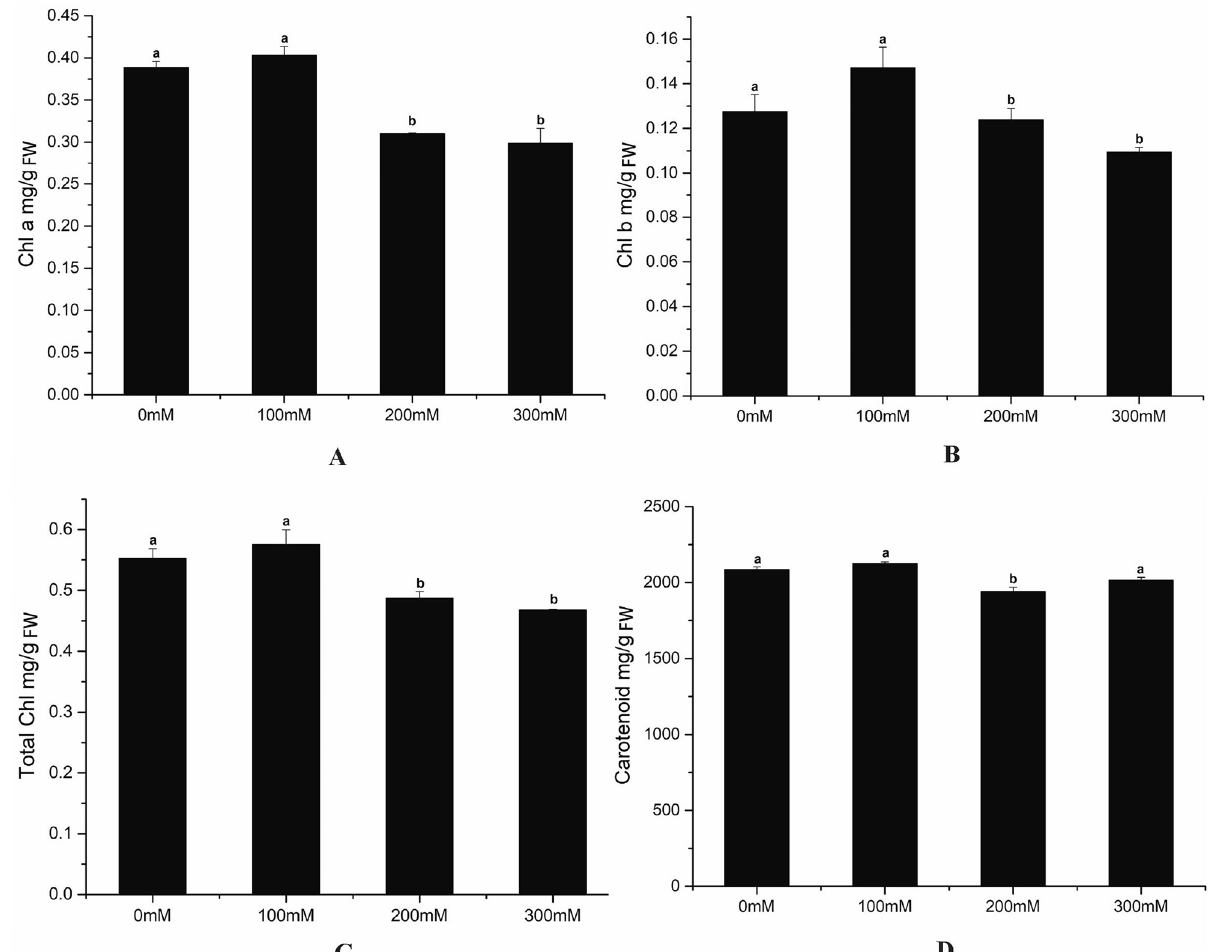
Figure 1. Changes in Photosynthetic Pigments contents under different NaCl concentrations. Chlorophyll a ( A ), Chlorophyll b ( B ), Total chlorophyll ( C ), Carotenoid ( D ) (The bars were standard deviation (SD) in